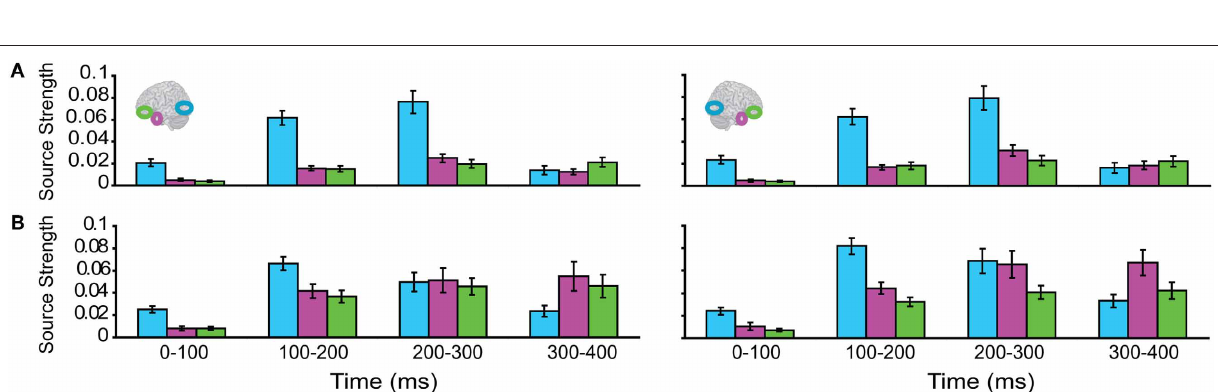
FIGURE 6 | Time binned (100ms) responses to visual trials (same as Figure 5).